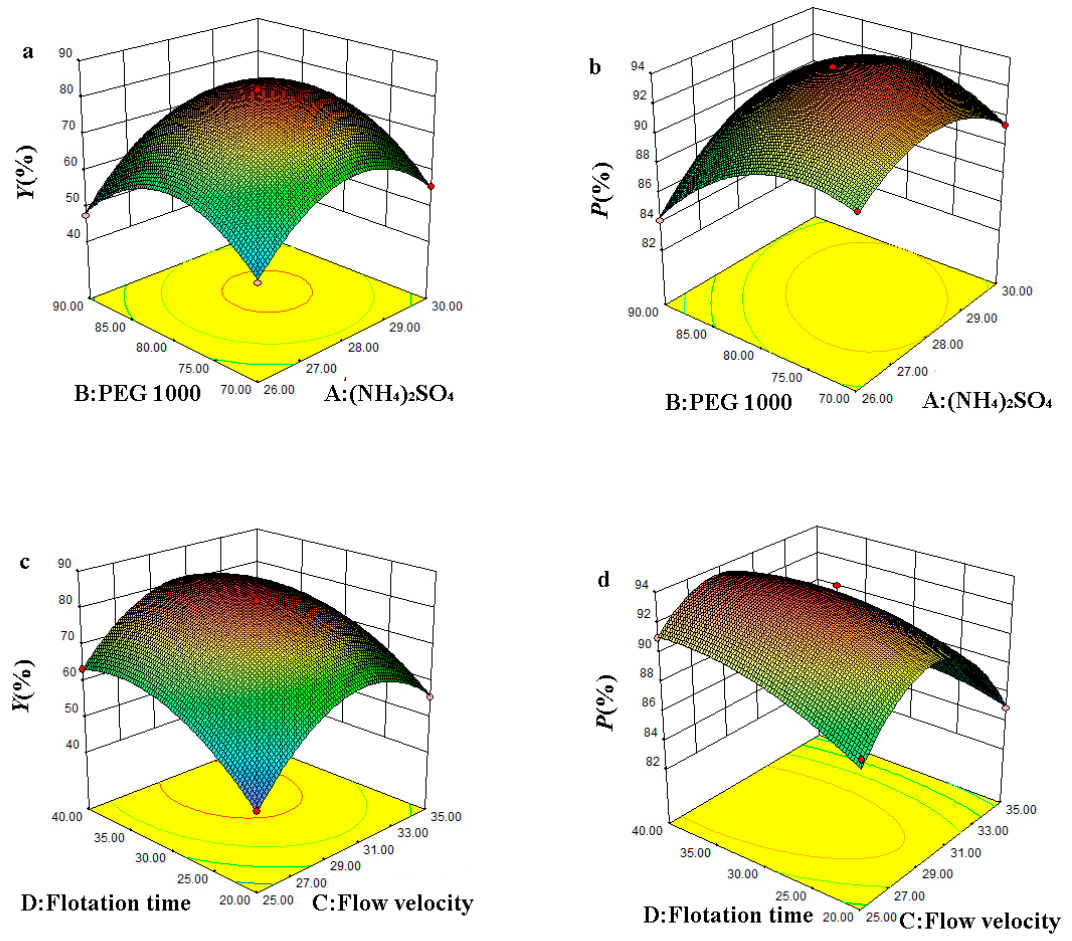
Figure 3. The response surface plots for Y ( a , c ) and P ( b , d ) of Figure 3 . The response surface plots for Y ( a , c ) and P ( b , d ) of OVA .